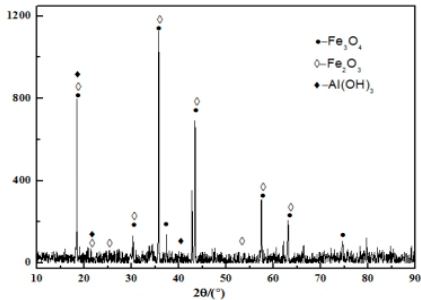
Figure 10. XRD pattern of slag after ultrasonic extraction.